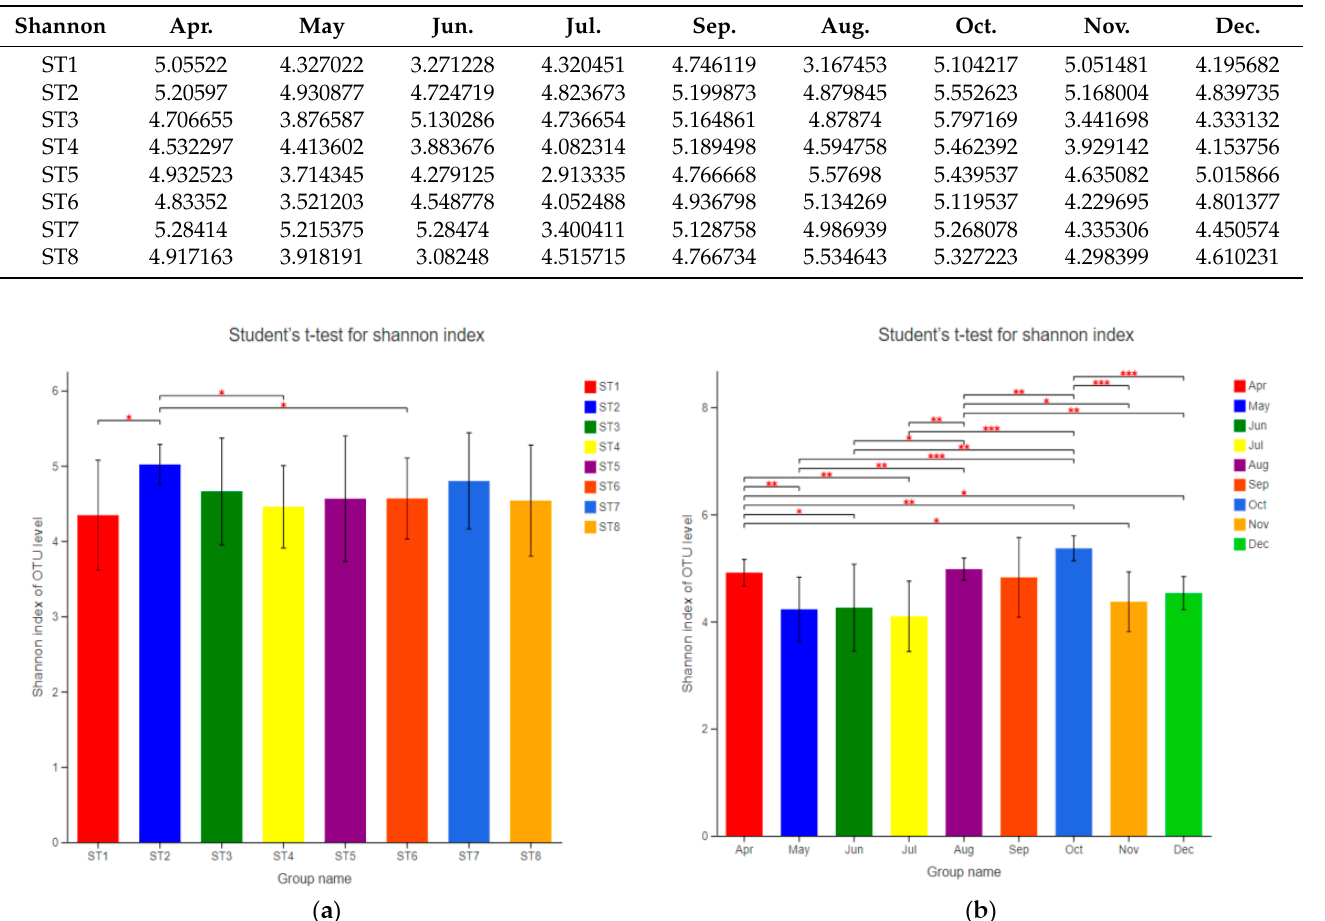
( b ) Figure 5. PCoA analysis of community composition (spatial groups ( a ) and temporal groups ( b )). Points of different colors or shapes represent samples of different groups. The closer the two sample points are, the more similar the species composition is.